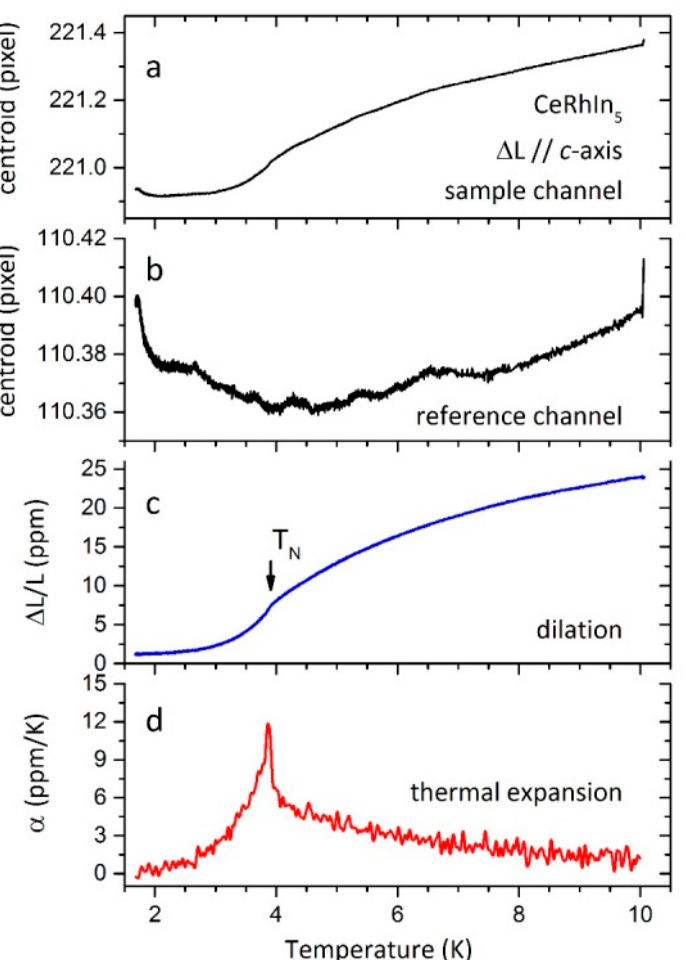
Figure 9. ( a ) FBG reflection centroid vs. temperature for the sample channel when a CeRhIn 5 sample is glued to the fiber. ( b ) FBG reflection centroid vs. temperature for the reference channel. ( c ) Computed dilation Δ L/L ( T) that is obtained by subtracting the reference channel from the sample channel and multiplying by a calibration constant. As it can be seen clearly here, the reference channel is essentially constant in the temperature range of the experiment, yet it is essential to remove systematic variations in the acquisition system that are common to both channels. ( d ) Computed coefficient of thermal expansion α (T). The noise level is <1 ppm. No correction was applied, neither by the thermal expansion of silica, or by strain transfer coefficient, with the notion of displaying just raw data. Note that the magnitude of the anomaly at the antiferromagnetic phase transition T N ≈ 3.8 K is in good agreement with results using capacitive dilatometry [25].